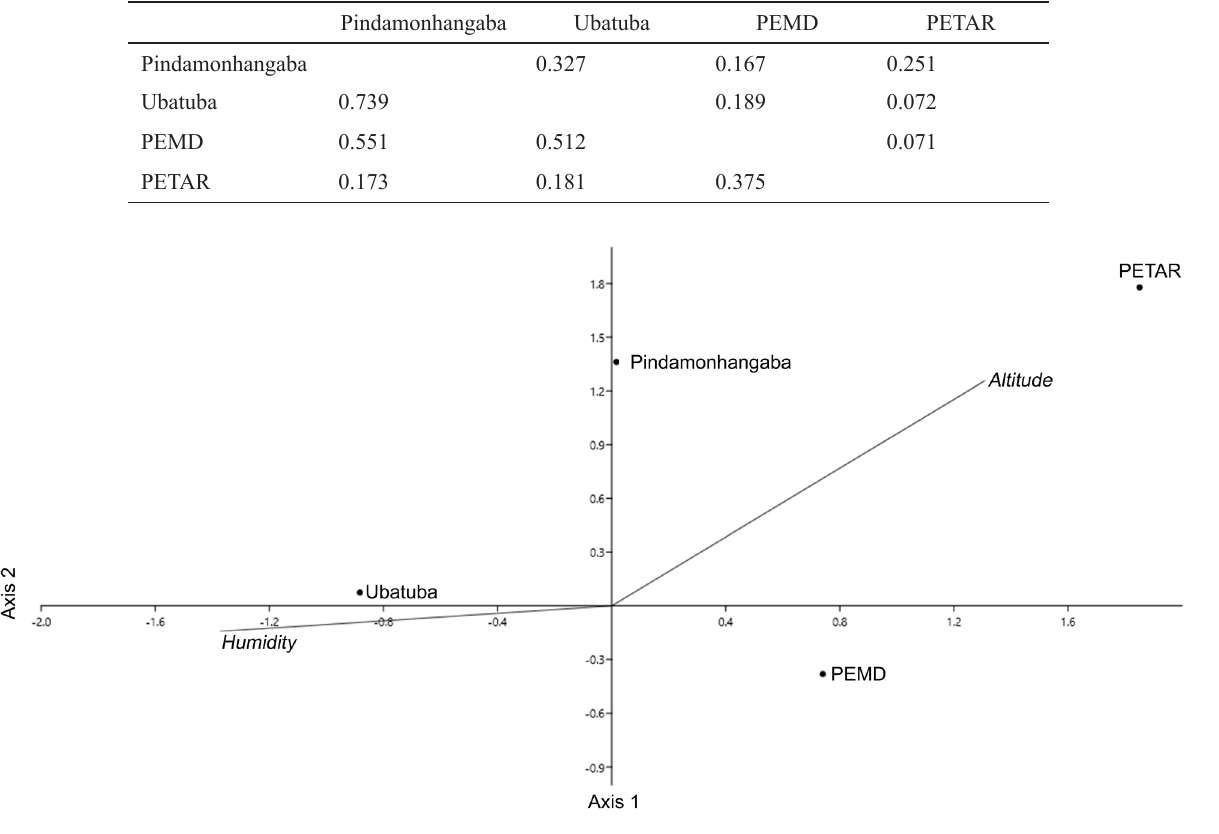
Fig 2. CCA ordination plot of the sampling sites in relation to the orchid bee and climatic and geographic variables. PEMD: Parque Estadual Morro do Diabo; PETAR: Parque Estadual Turístico do Alto